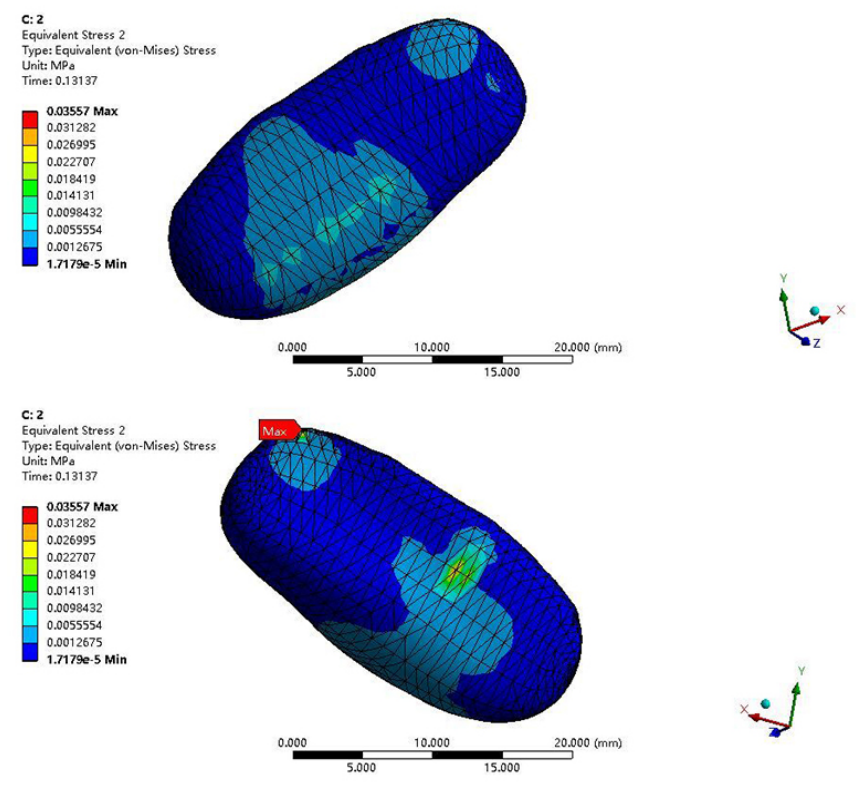
Fig. 4. Stress change at the start of the subacromial bursa drawing